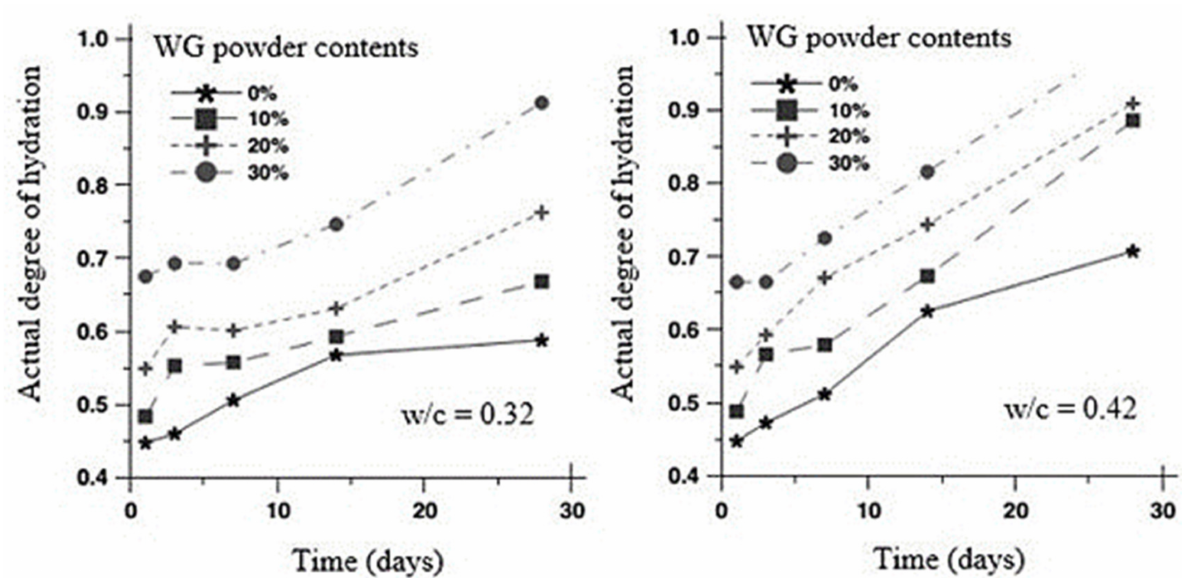
Figure 5. Degree of hydration in cement pastes with various amounts of WG powder [62].